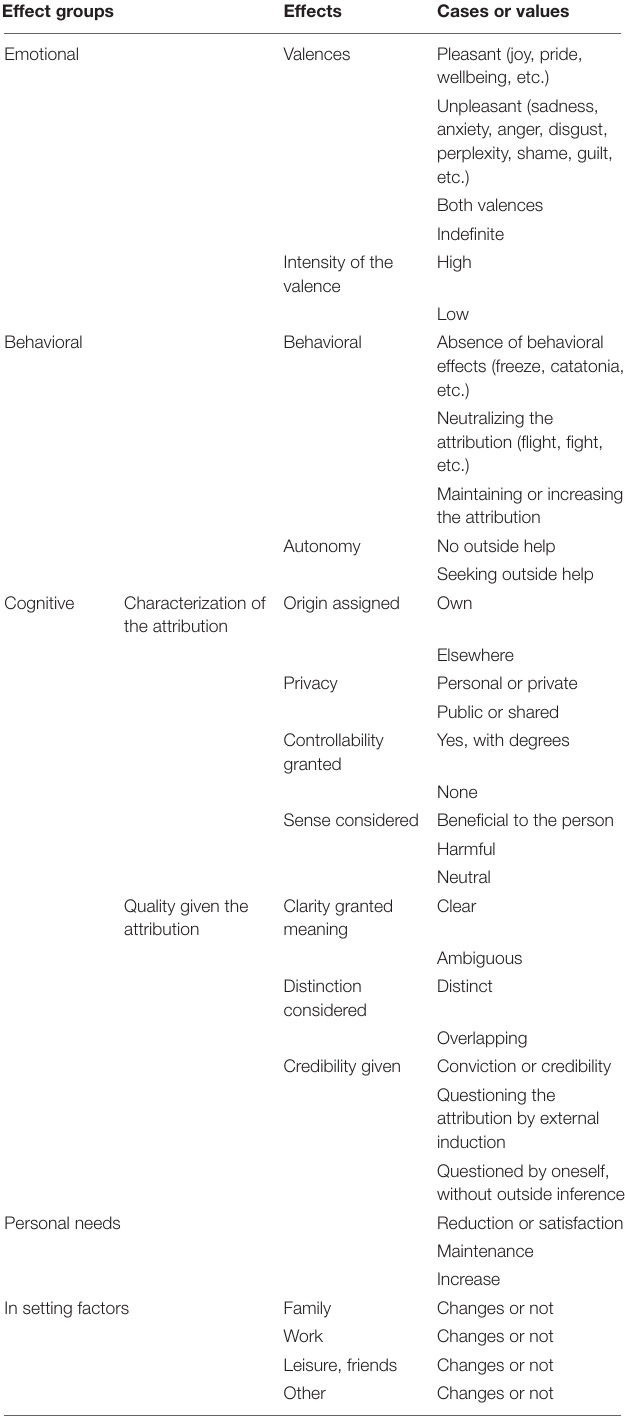
TABLE 3 | Effects of the framework